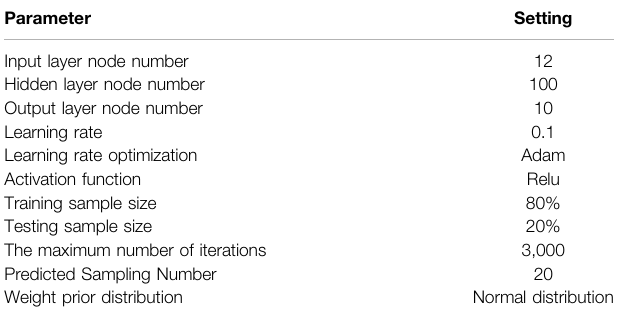
TABLE 5 | BNN parameter